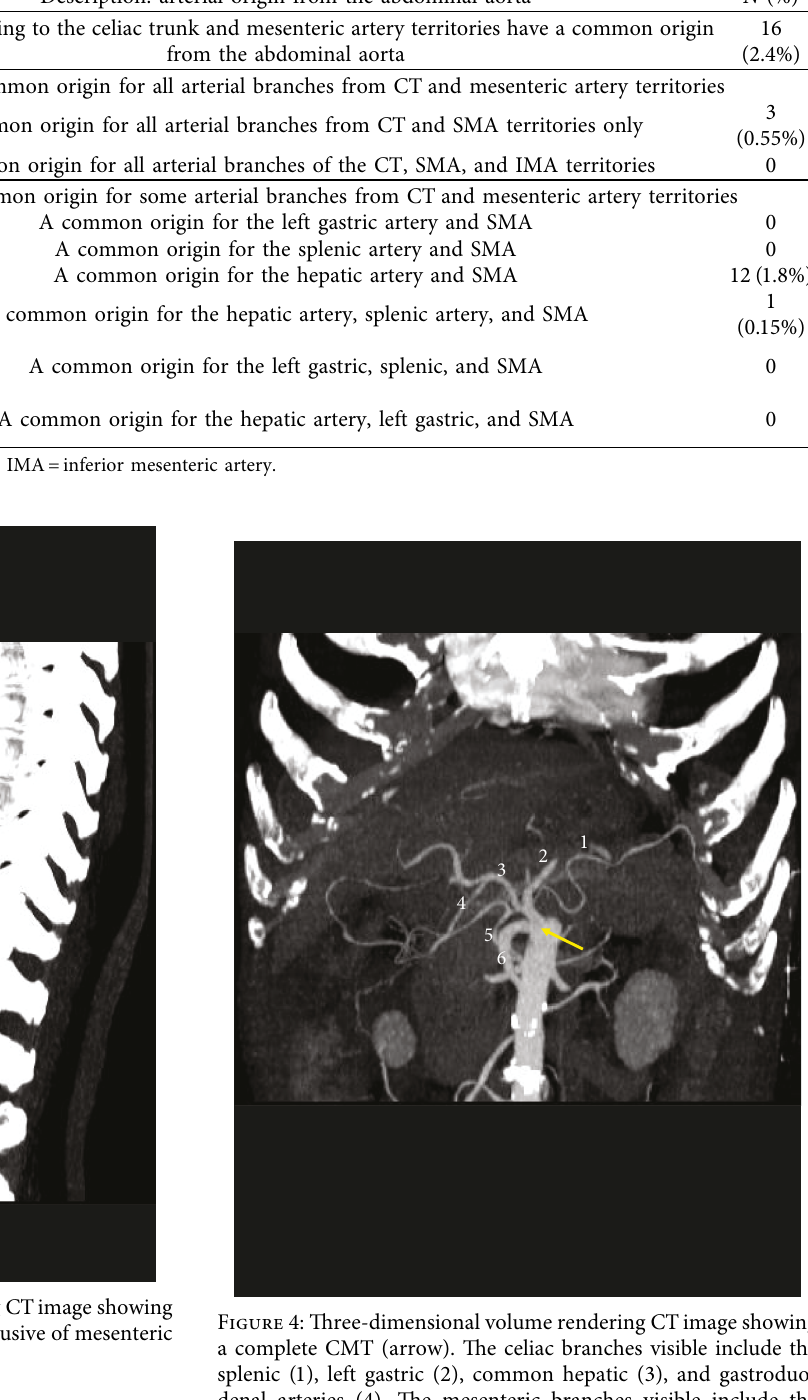
Table 1: Anatomic variants of the ventral branches of the abdominal aorta in 665 persons. Description: arterial origin from the abdominal aorta